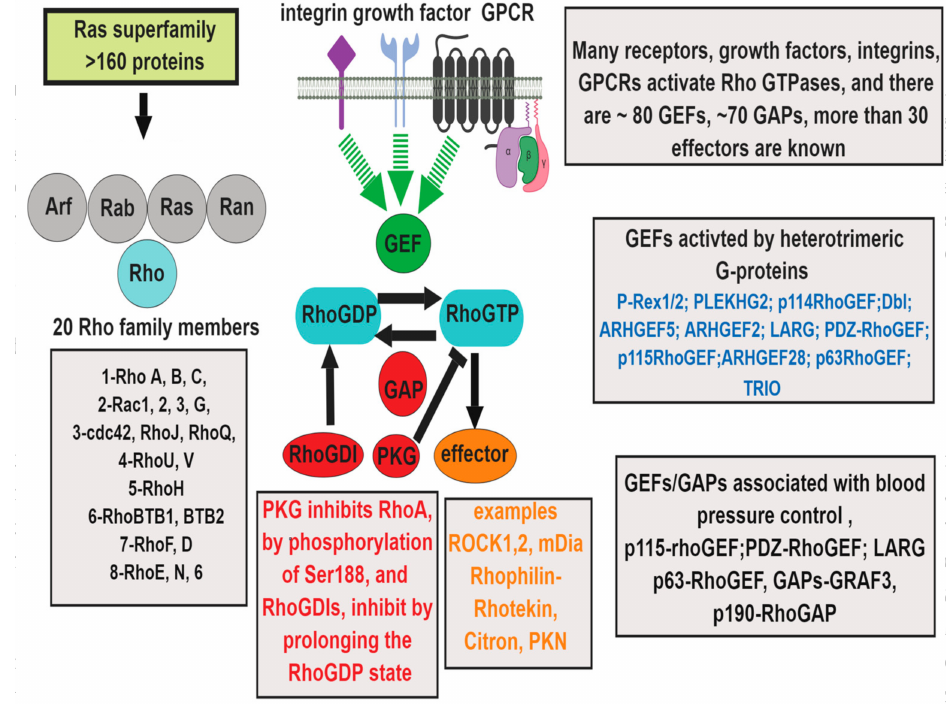
Figure 1. Regulation of Ras-homologous (Rho) GTPase signaling: Rho GTPases belong to the Ras superfamily of more 160 proteins, with six subfamilies [26]. The Rho subfamily has more than 20 members, involved in multiple signal transduction pathways. Control of RhoGTPases is achieved by guanine nucleotide exchange factors (GEFs) and GTPase-activating proteins (GAPs) [6]. Integrins, growth factors, and vasoactive G-protein coupled receptors (GPCRs) linked to heterotrimeric G 12 / 13 proteins activate RhoGTPases by mechanisms involving RhoGEFs and RhoGAPs and play an important role in vascular diseases.(Abbreviations: Protein kinase N (PKN), Protein kinase G (PKG), ADP ribosylation factor (Arf ) GTP regulator associated with FAK (Graf), Redox sensing transcriptional repressor